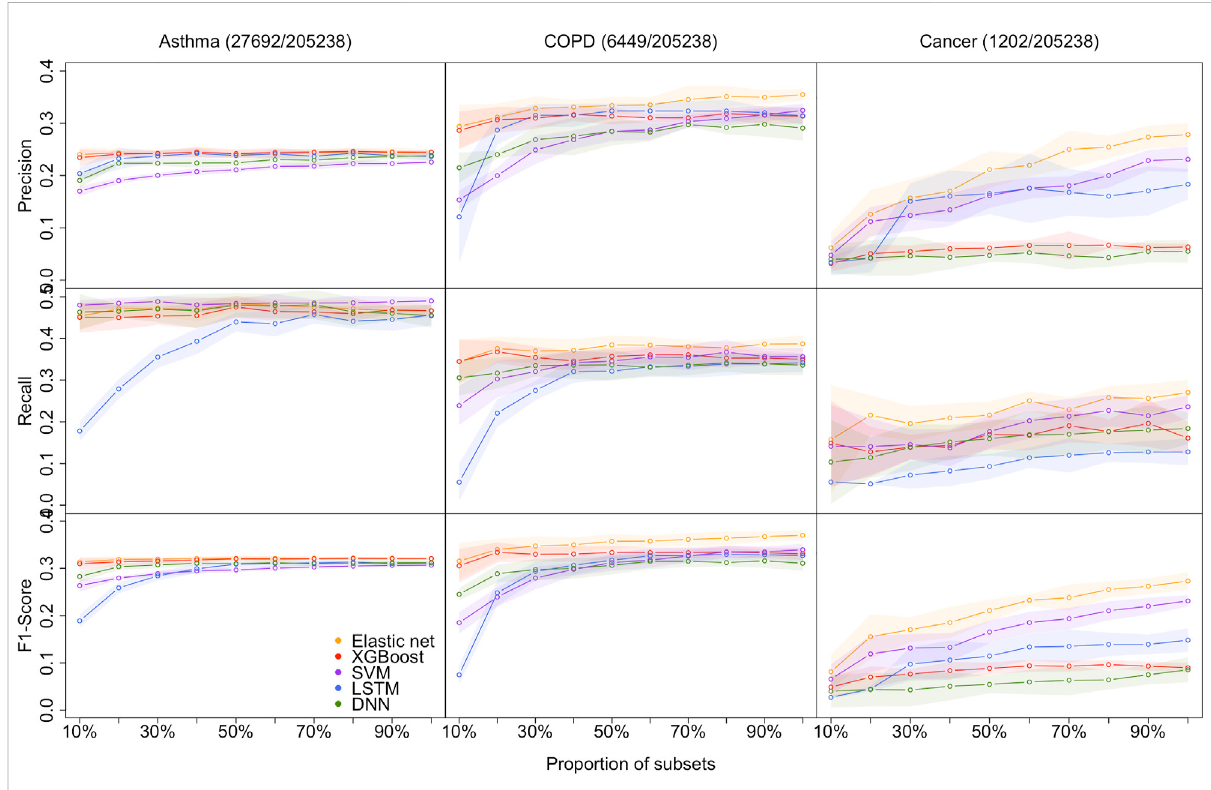
FIGURE 2 Models performance of the 5 methods with the 10 different sample size for predicting asthma, COPD, and lung cancer, respectively. Performances are shown by precision, recall, and F1-score. the shaded parts are the 1 standard error con fi dence